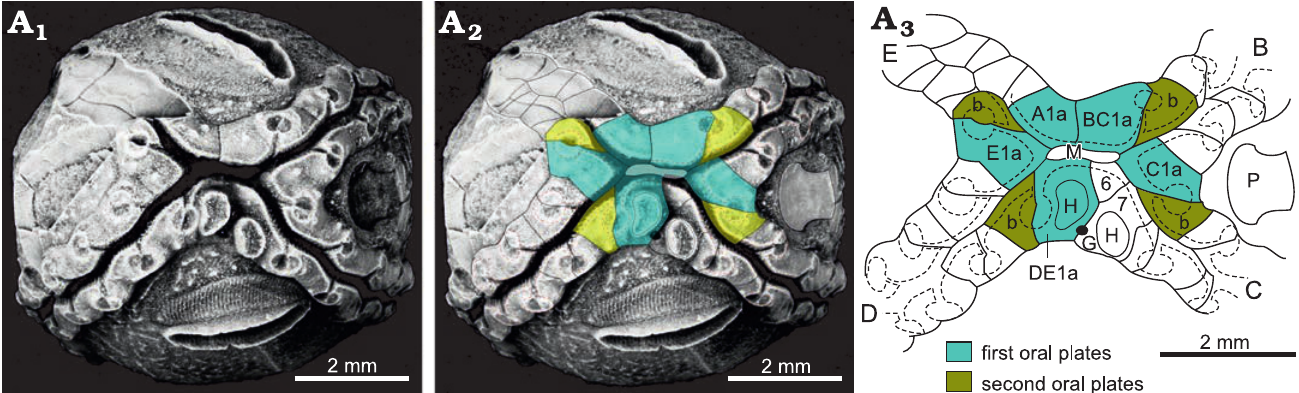
Fig. 17. Oral and ambulacral plating of the callocystitid Lipsanocystis traversensis Ehlers and Leighley, 1922 (UMMP 33311), Middle Devonian, Michigan, USA, illustrating the alternative “B–E the same” pattern of primary brachioles in which all four ambulacra have the first brachiole facet to the left. A 1 , oral view of showing the four ambulacra and double hydropore; A 2 , the same with interpretation of oral plates superimposed; A 3 , interpretation of oral and ambulacral plating. Ambulacrum A stopped developing after the first plate formed. In ambulacra B–E the first brachiole is to the left and the second to the right. B–E, ambulacra; A1a–E1a, first plates in corresponding ambulacra; b second plates in ambulacra B–E; G, gonopore; H, hydropore; M, mouth; P, periproct; 6, 7, orals 6 and 7 under the conventional interpretation. Dashed line outlines of ambulacra and brachiole facets. Only the first two ambulacral plates are shaded.